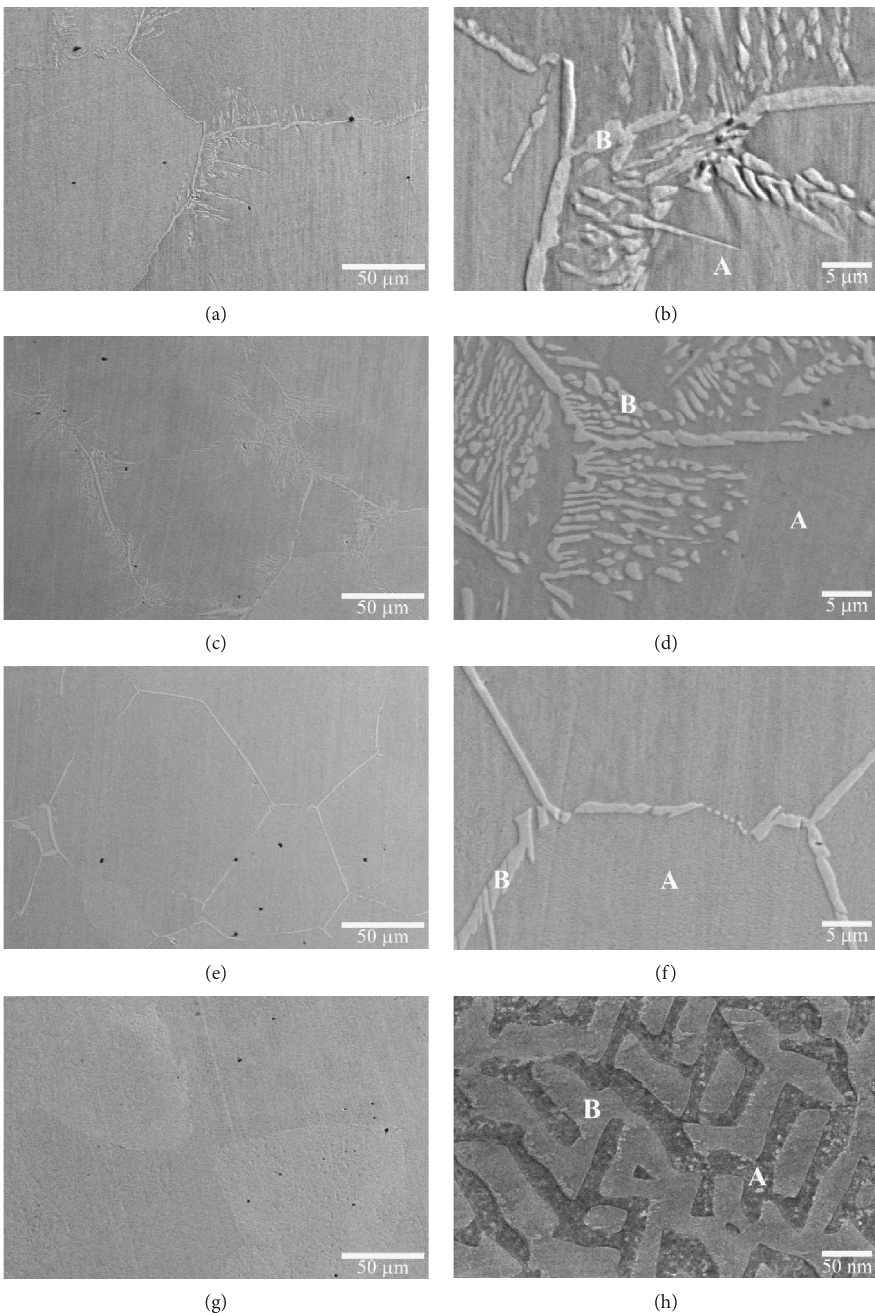
Figure 2: SEM-BSE images of the alloys: (a, b) Cr-0.3, (c, d) Cr-0.5, (e, f) Cr-0.7, and (g, h)